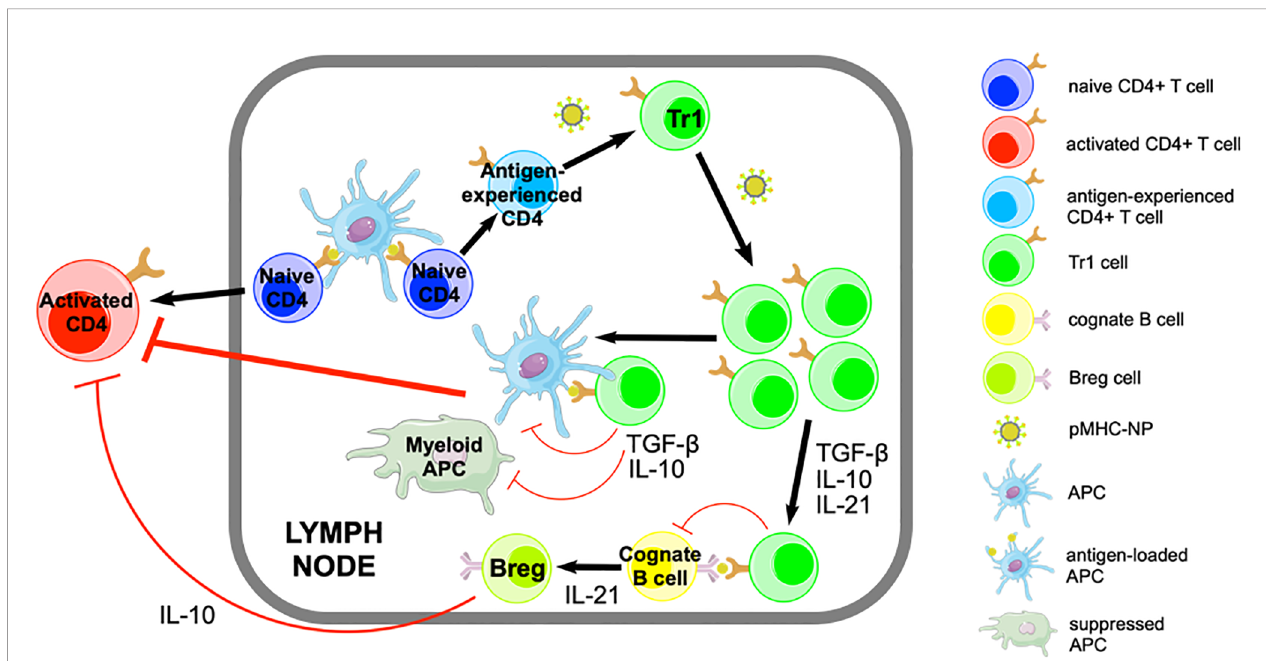
FIGURE 1 | Pharmacodynamic activity of pMHCII-NPs. pMHCII-NPs target autoantigen-experienced CD4+ T cells and induce their differentiation into memory TR1-like cells followed by their systemic expansion. This process involves IFN- g and IL-10 signaling, but does not require IL-27. pMHCII-NP-induced TR1-like cells carry out their regulatory function by suppressing other autoreactive T-cell speci fi cities via IL-10, IL-21 and TGF- b . IL-10 and TGF- b have immunosuppressive effects on autoantigen-loaded APCs, inhibiting their proin fl ammatory function and thus avoiding the activation of other non-cognate autoreactive T cells. pMHCII-NP-induced TR1-like cells can also interact with cognate B-cells, promoting their differentiation into Bregs in part via IL-21. Figure adapted from Clemente-Casares et al.